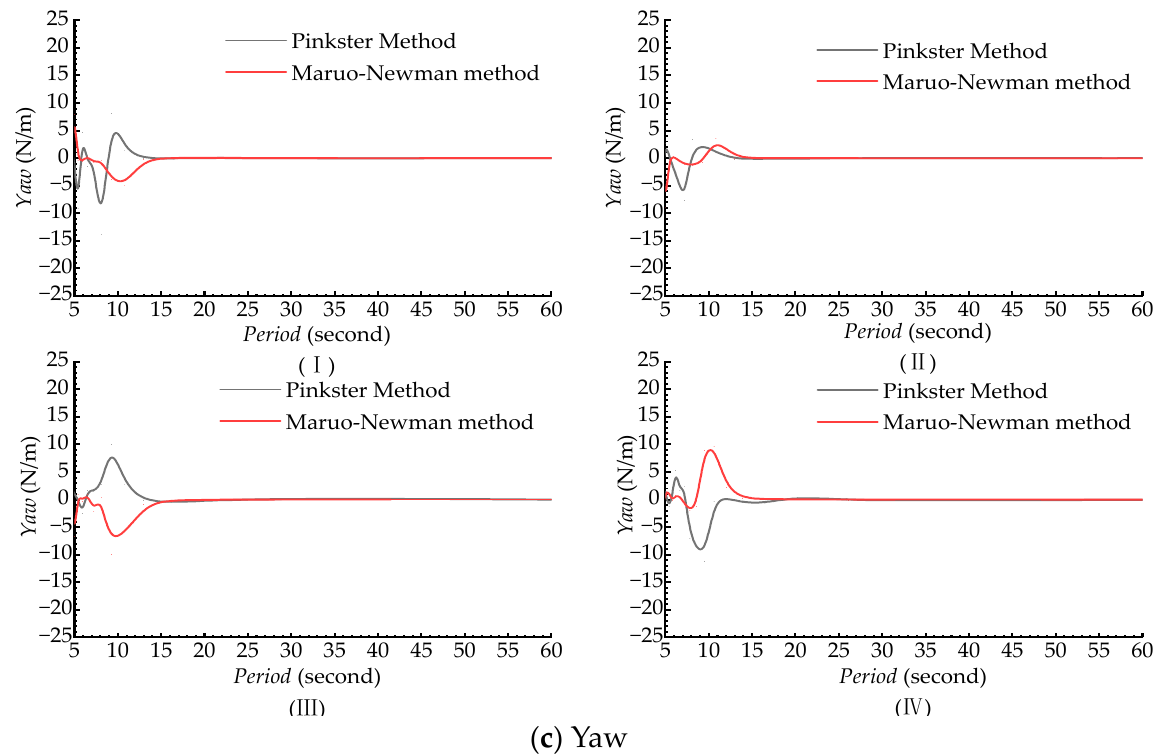
Figure 6. Mean wave drift forces and moments on the structure. Note: (I) mesh size, 0.8 m; (II) mesh size, 1.0 m; (III) mesh size, 1.2 m; (IV) mesh size, 1.5 m.